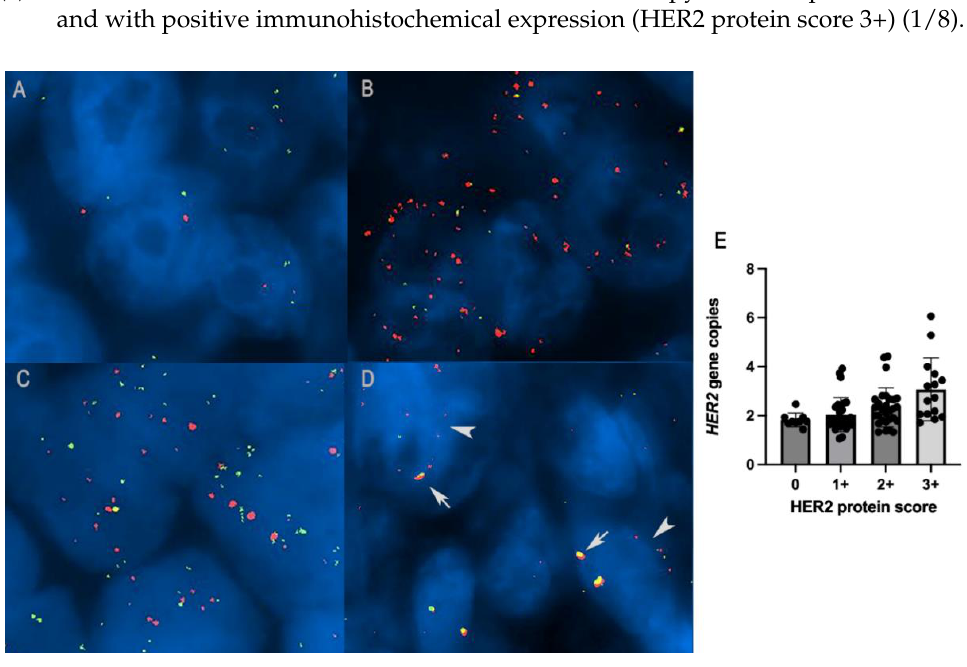
Figure 4. ( A ) HER2 diploid in canine mammary carcinoma: two gene copies of both HER2 (red signal) and CRYBA1 (green signal), FISH. ( B ) HER2 amplification in canine mammary carcinoma: HER2/CRYBA1 > 2, FISH. ( C ) HER2/CRYBA1 co-amplification/polysomy: increased copy numbers of both HER2 and CRYBA 1 (> 4 gene copies). ( D ) HER2/CRYBA1 fusion pattern: close co-localization of HER2 and CRYBA1 , interpreted as translocation and fusion of the two genes (arrows) together with non-fused alleles in the same nuclei (arrowheads). ( E ) Histogram representation of the correlation between HER2 overexpression with an increased number of HER2 gene copies ( p = 0.01, R = 0.24; Spearman test).